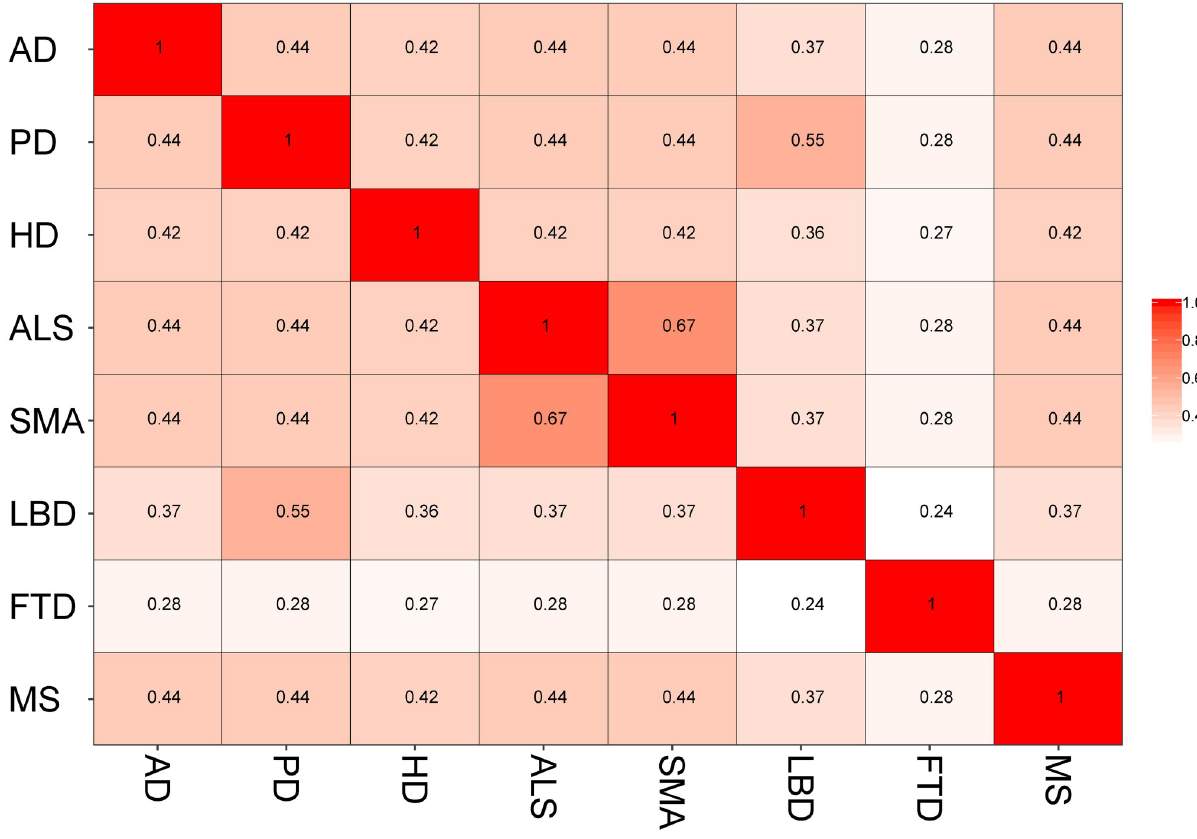
Fig 6. Semantic similarity matrix for DO terms. AD-Alzheimer’s disease, ALS-Amyotrophic lateral sclerosis, FTD-Frontotemporal dementia, HD-Huntington’s disease, LBD-Lewy body disease, MS-Multiple sclerosis, PD-Parkinson’s disease.